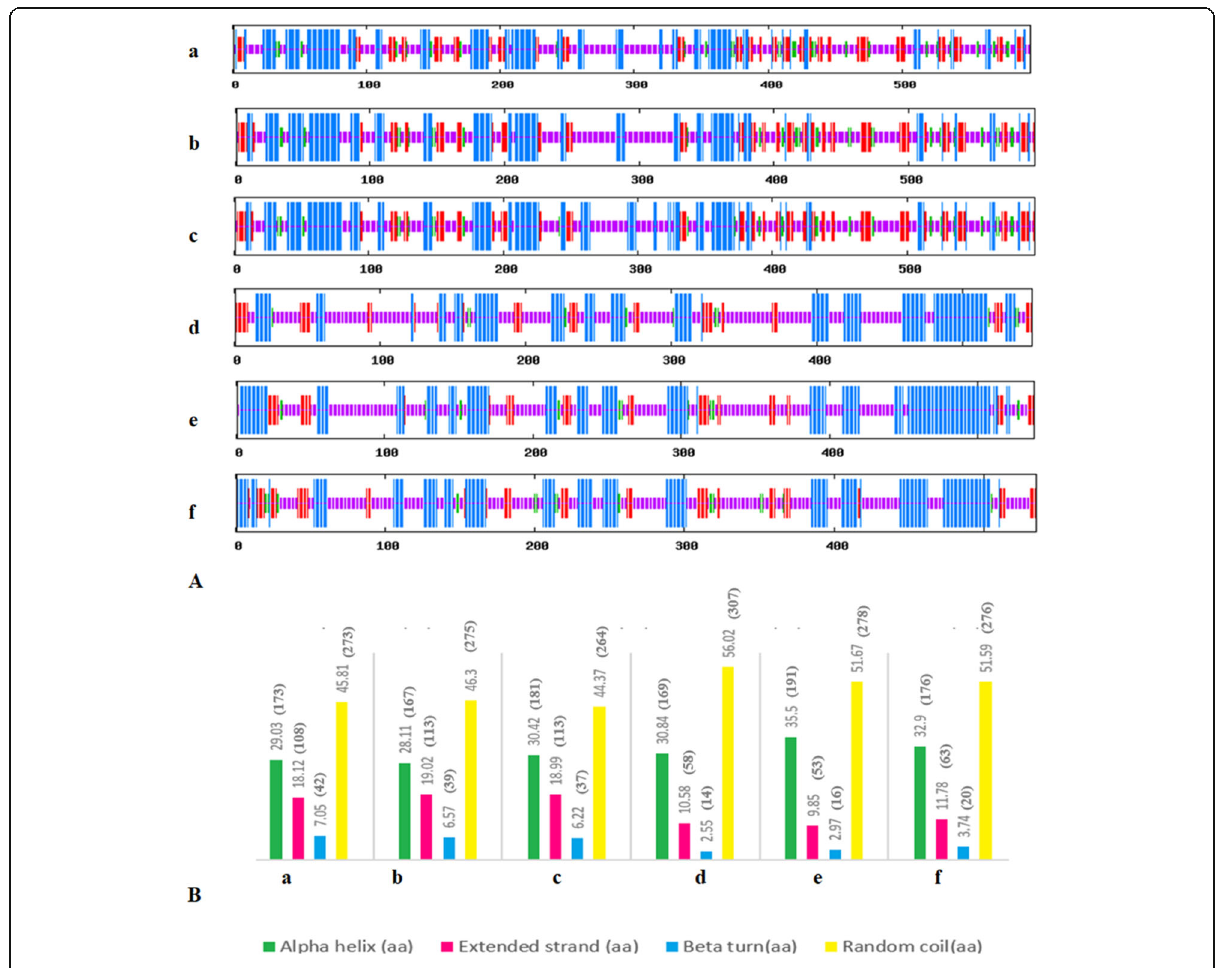
Fig. 7 Structural analysis of proteins. A Diagrammatical representation of Secondary structures (a: PePI-PLC6A; b: DcPI-PLC6A; c: AsPI-PLC6; d: